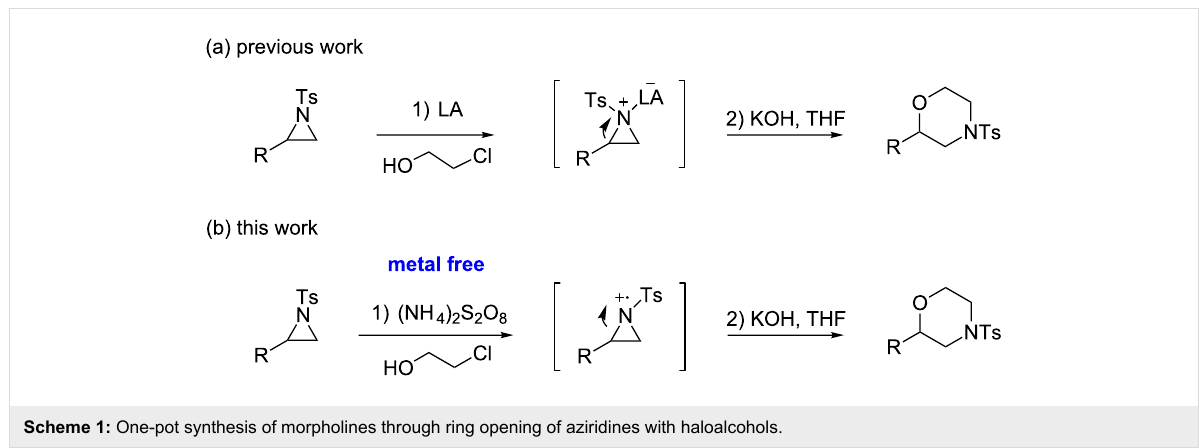
Scheme 1: One-pot synthesis of morpholines through ring opening of aziridines with haloalcohols.